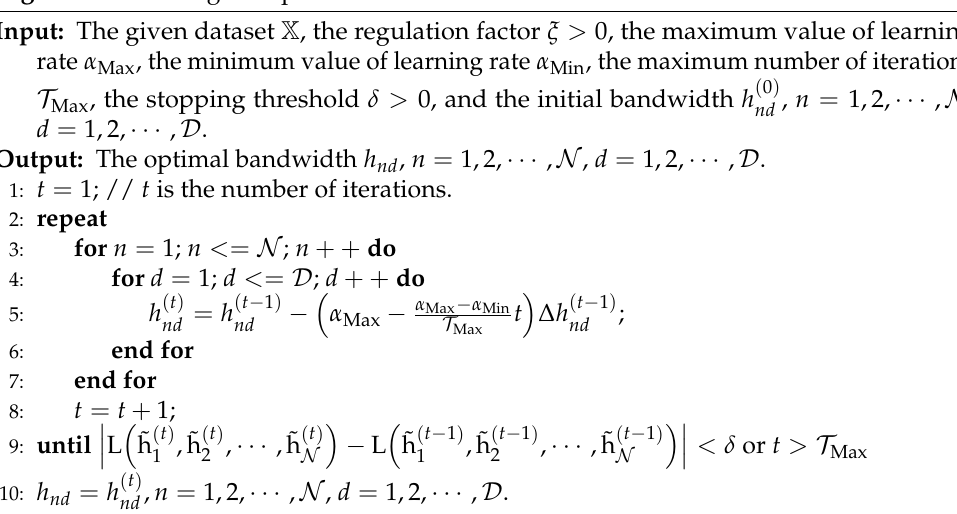
Algorithm 1 Solving the optimal bandwidths for IVKDE.